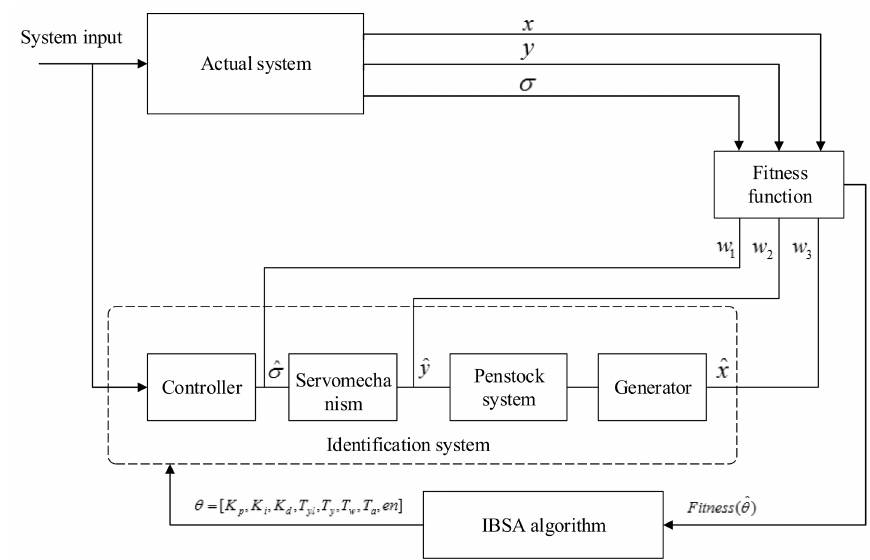
Figure 6. The parameter identification model of PTGS based on